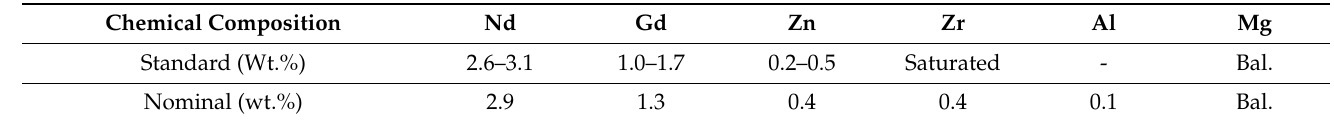
Table 1. Chemical composition of the starting